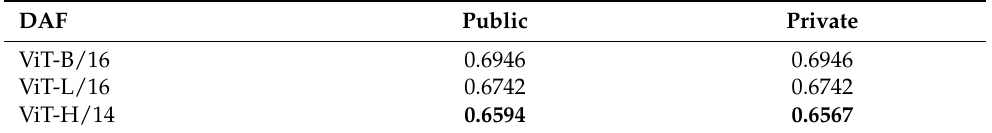
Table 4. Comparisons with previous results for the backbone of GeoLifeCLEF 2022. The ViT models are B/16, L/16, and H/14.